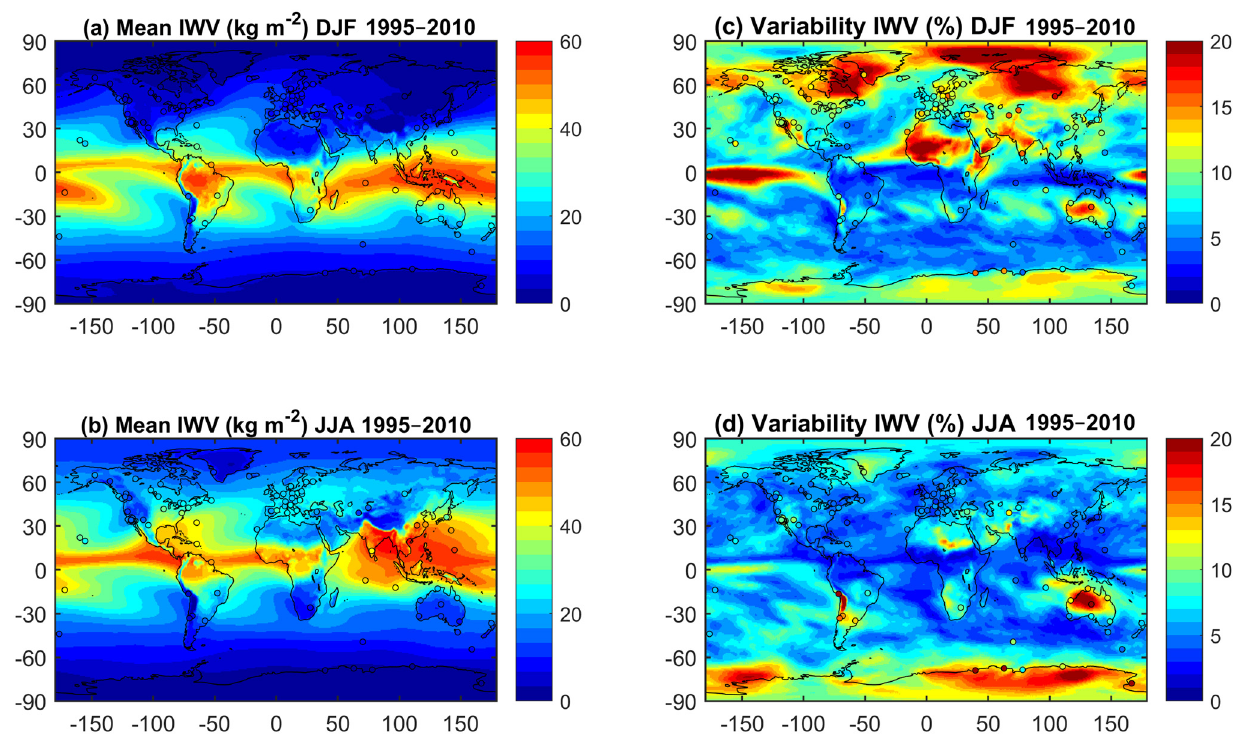
Figure 2. (a) Mean IWV for DJF 1995–2010 from ERA-Interim (shading) and GPS (filled circles); (b) same as panel (a) for JJA. (c) Relative variability in percentage (%) (standard deviation of the IWV series divided by its mean) for DJF 1995–2010; (d) same as panel (c) for